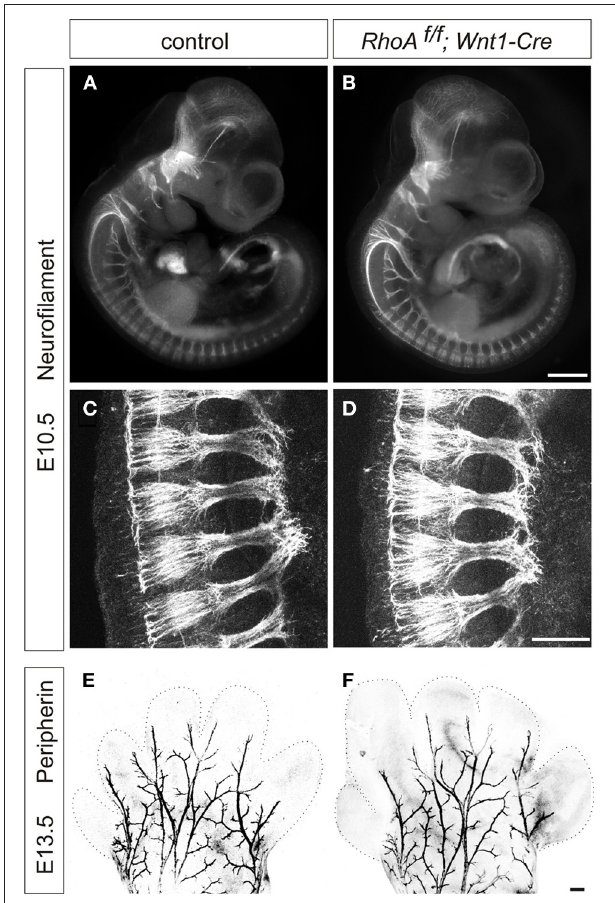
FIGURE 3 | Whole-mount neurofilament and peripherin staining. (A–D) Control and RhoA f / f ; Wnt1-Cre embryos were stained with anti-neurofilament (NF) antibody at E10.5. (C,D) show enlarged views of Plexus region. (E,F) Forelimbs of control and RhoA f / f ; Wnt1-Cre embryos were stained with anti-peripherin antibody at E13.5. There were no obvious defects in NF + or peripherin + axons in RhoA f / f ; Wnt1-Cre embryos compared to control embryos. Scale bars, 100 µ m (B,F) and 20 µ m (D) .